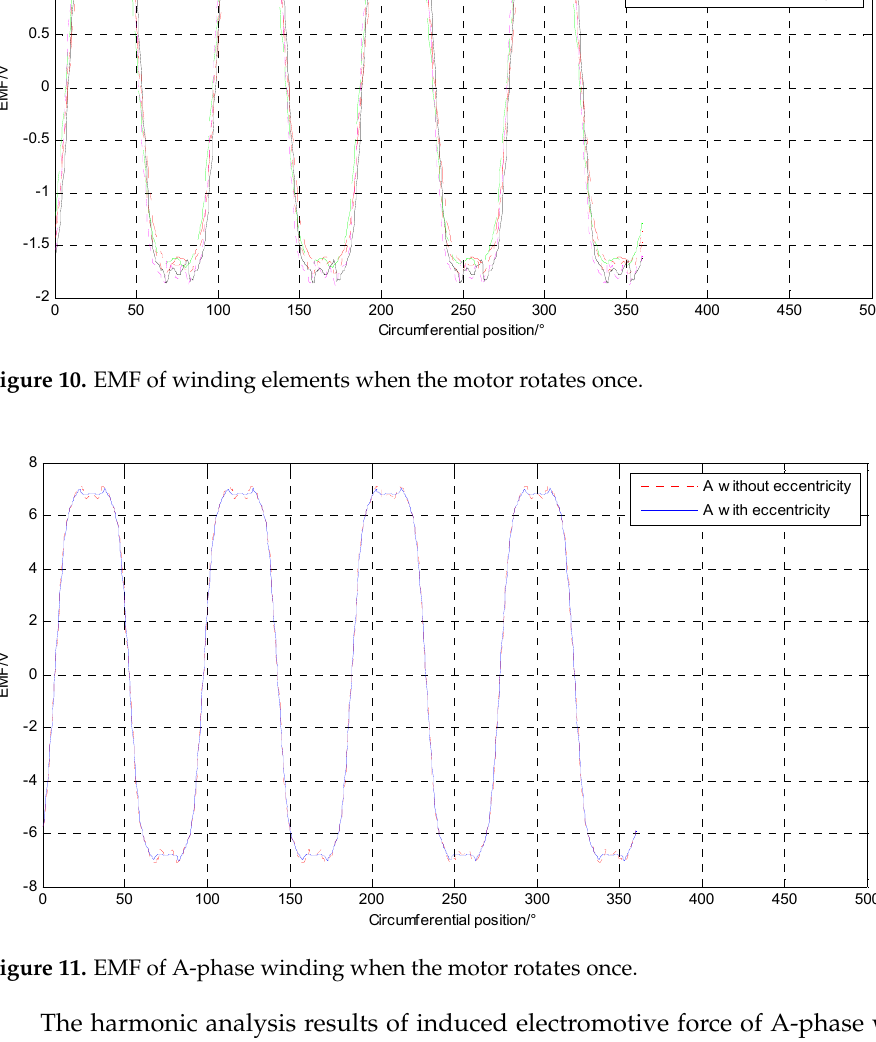
healthy state is only composed of harmonic components of multiples of 4. The 4th and 12th harmonic components are the main, and the amplitudes of others are very small. Static eccentricity does not change the periodicity of induced electromotive force, and the 4th and 12th harmonic components are also the